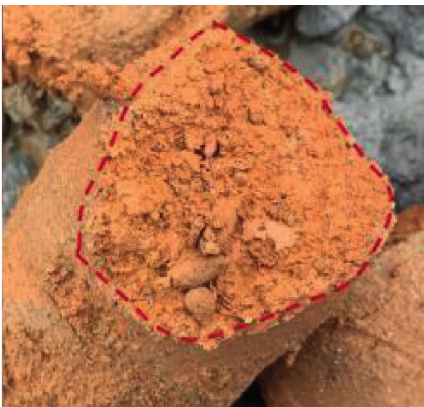
Figure 1: Main characteristics of soil core description.